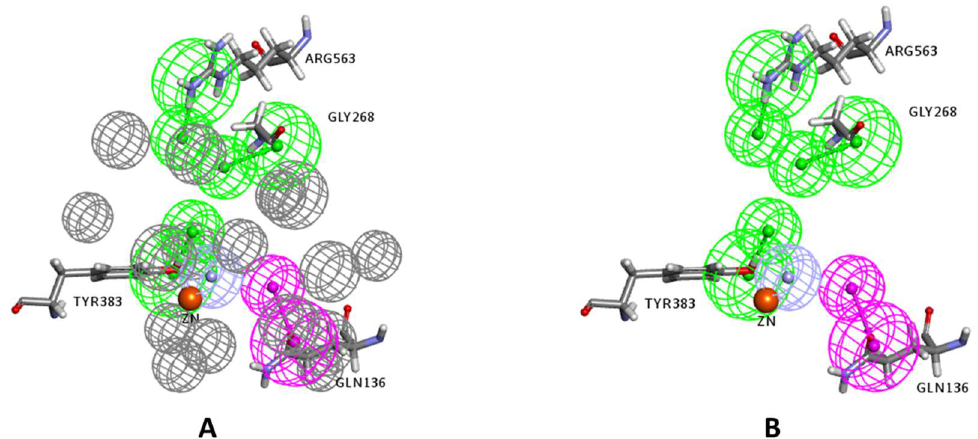
Figure 5. The final generated structure-based pharmacophore model with ( A ) and without ( B ) exclusion constraints (excluded volumes). The feature types are: HBD (magenta), HBA (green), ZBF (light blue), and excluded volumes (gray). The zinc atom is shown as an orange sphere, and key interacting amino acids are labeled and shown in sticks.